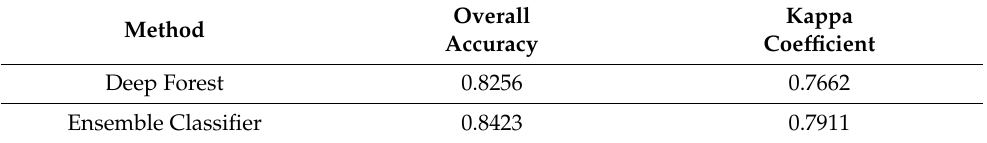
Table 10. Comparison of our proposed ensemble classifier with the deep forest